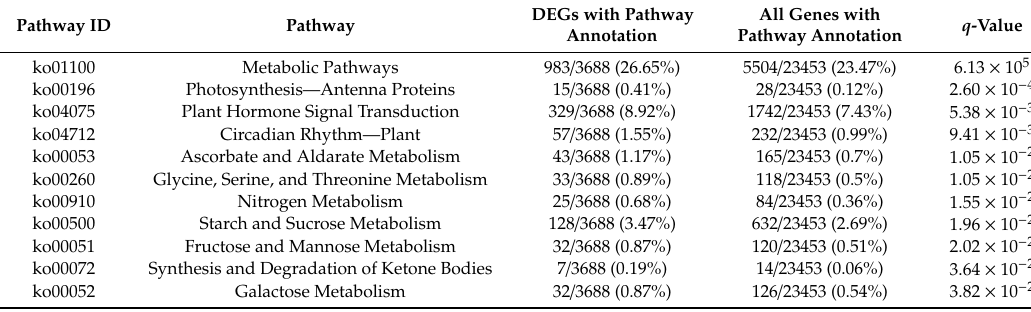
Table 1. Significantly enriched KEGG pathways of significantly differentially expressed genes in roots of “Nanlin895” exposed to boron deficiency.